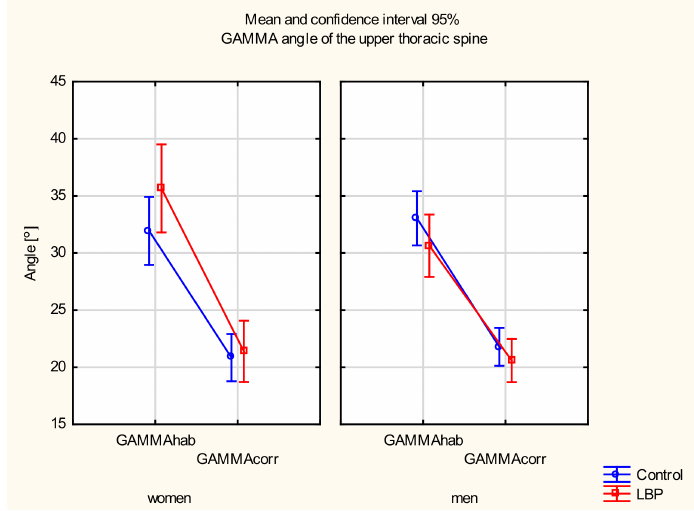
Figure 5. Mean and 95% CI of the GAMMA angle of the upper thoracic spine in women and men, in habitual (hab) and corrected (corr) positions, in the control and LBP groups.